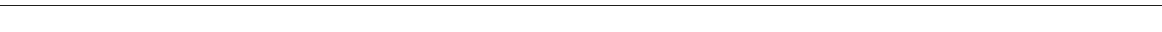
Fig. 4 Human UC-MSCs favor mitochondrial exchange among injured RPTECs through microtubules. a Representative phase contrast images showing the morphology of control RPTECs, cisplatin-treated RPTECs alone, or co-cultured with UC-MSCs ( n = 6 independent experiments). Cytoplasmic protrusions connecting adjacent tubular cells (indicated by arrowheads) markedly decreased in response to cisplatin and were normalized by UC-MSC exposure. Scale bar 10 μ m. b Representative images and quanti fi cation of mitochondrial exchange in control RPTECs, cisplatin-treated RPTECs alone, or co-cultured with UC-MSCs ( n = 4 independent experiments). Two different populations of cultured tubular cells were obtained by transfecting mitochondria with a fusion construct of E1 alpha pyruvate dehydrogenase leader sequence with GFP (green) or RFP (red) and the mitochondrial exchange was assessed as the co-localizing signals (yellow). Enlarged detail of the mitochondria traf fi cking among RPTECs through cytoplasmic protrusion is shown in inset. In additional samples, cisplatin-treated RPTECs were exposed to taxol in co-incubation with UC-MSCs ( n = 4 independent experiments). Nuclei are counterstained with hoechst (blue). Scale bar 10 μ m. ** P < 0.01, *** P < 0.001 vs Control and °°° P < 0.001 vs Cispl and ## P < 0.01 vs Cispl + UC-MSCs using ANOVA corrected with Bonferroni coef fi cient. c Representative images of immuno fl uorescence analysis of tubulin network (green) and SOD2-labeled mitochondria (red) in control RPTECs, cisplatin-treated RPTECs alone or co-cultured with UC-MSCs ( n = 4 independent experiments). Microtubule cell – cell interconnection markedly disarranged upon cisplatin exposure in parallel to mitochondria re-distribution in the perinuclear region of injured RPTECs. Co-culture with UC-MSCs normalized RPTEC tubulin cytoskeletal architecture and the mitochondrial distribution along tubulin-rich protrusions. Nuclei are counterstained with DAPI (blue). Scale bar 10 μ m. Data in b are expressed as mean ±